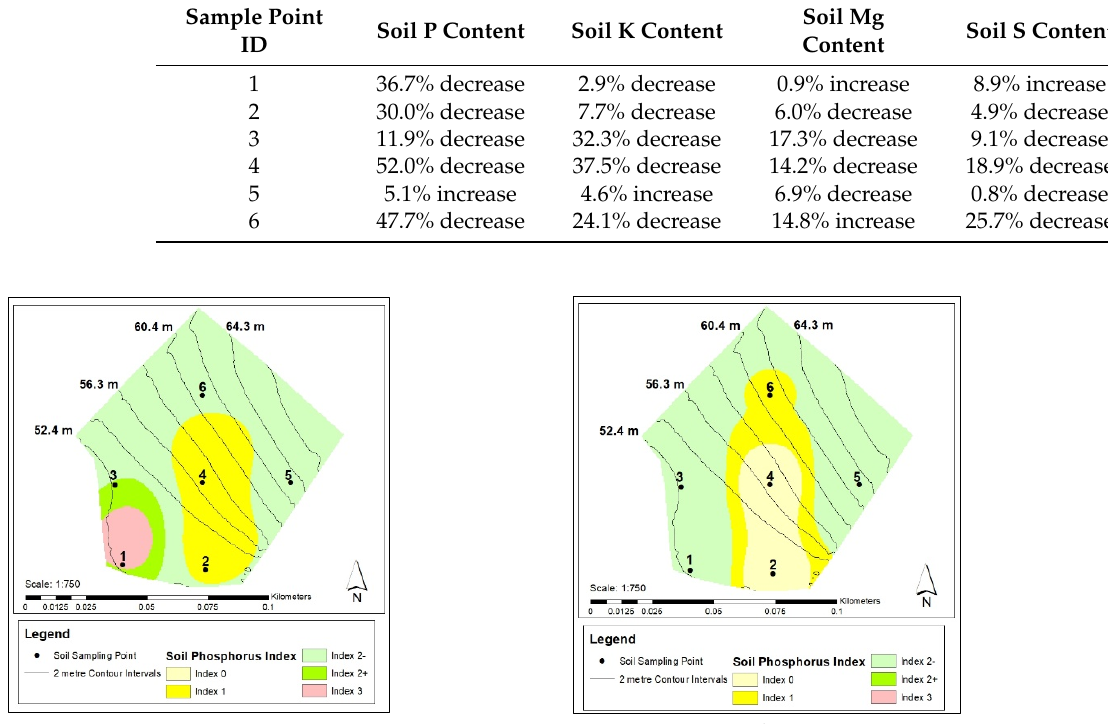
Table 1. Percentage change in soil-nutrient content (mg L − 1 ) from 2020 to 2021 per sample point.